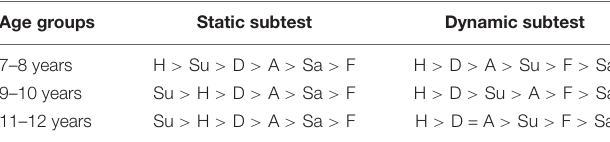
TABLE 5 | The classification of the recognition of facial emotions of static and dynamic subtest according to age